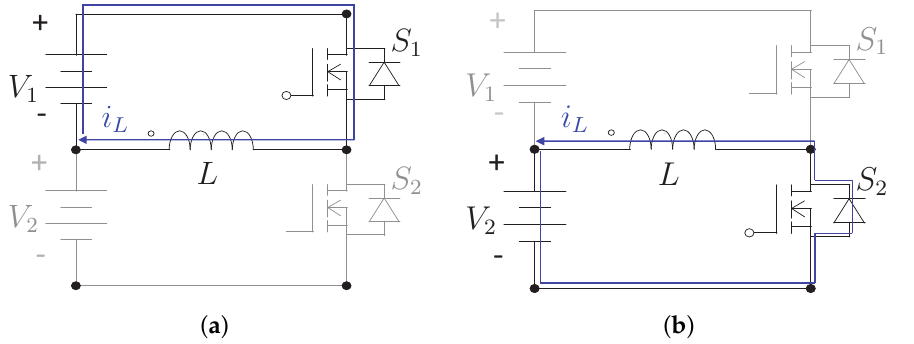
Figure 5. Operation of the module of the switched-inductor architecture, ( a ) on-state, ( b ) off-state. Equation (1) rules the behavior of the current through the inductor in the on state of the switch S 1 . Where i L is the current through the inductor L , V 1 is the voltage in cell 1, and L is the value of the inductance of the inductor. On the other hand, Equation (2) rules the behavior of the current through the inductor in the off state of the switch S 1 . In this case, V 2 is the voltage in cell 2, while the other symbols indicate the same variable indicated in the previous